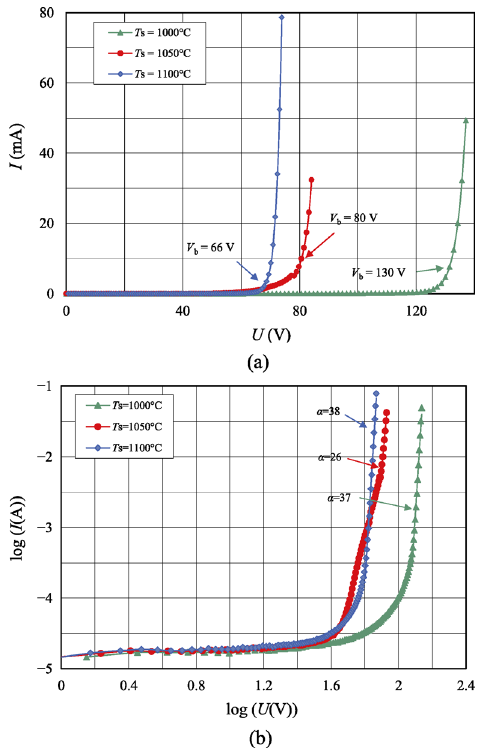
Fig. 7 Current–voltage characteristics of multilayer varistors sintered at various temperatures: (a) I – U , (b) log I –log U